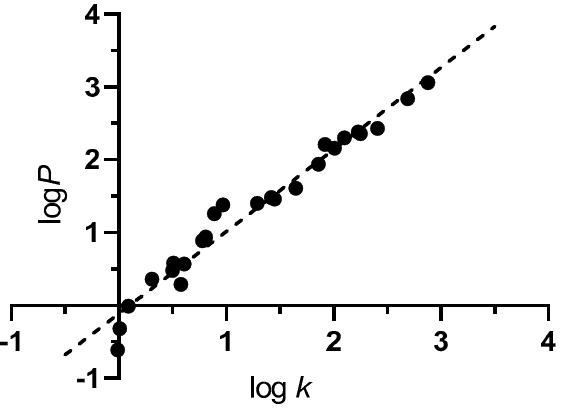
Figure 3. Linear regression of log P (calculated) plotted against log k (experimental). Equation: log P = 1.127 log k − 0.1149. (R 2 = 0.9664, n = 25).